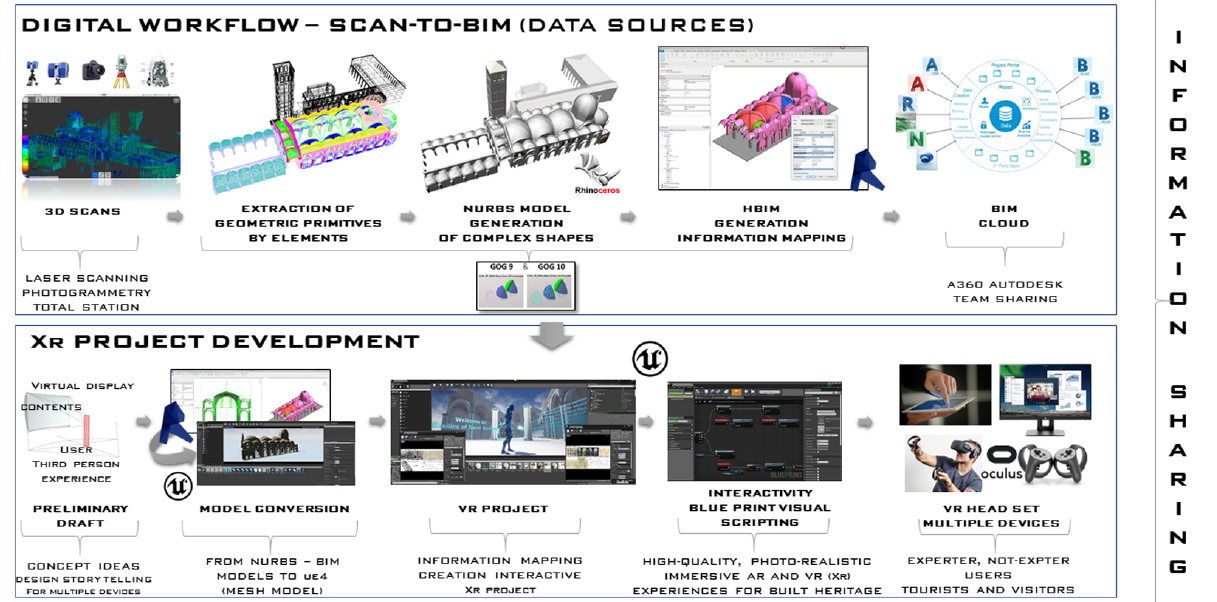
Figure 2. The Xr project development